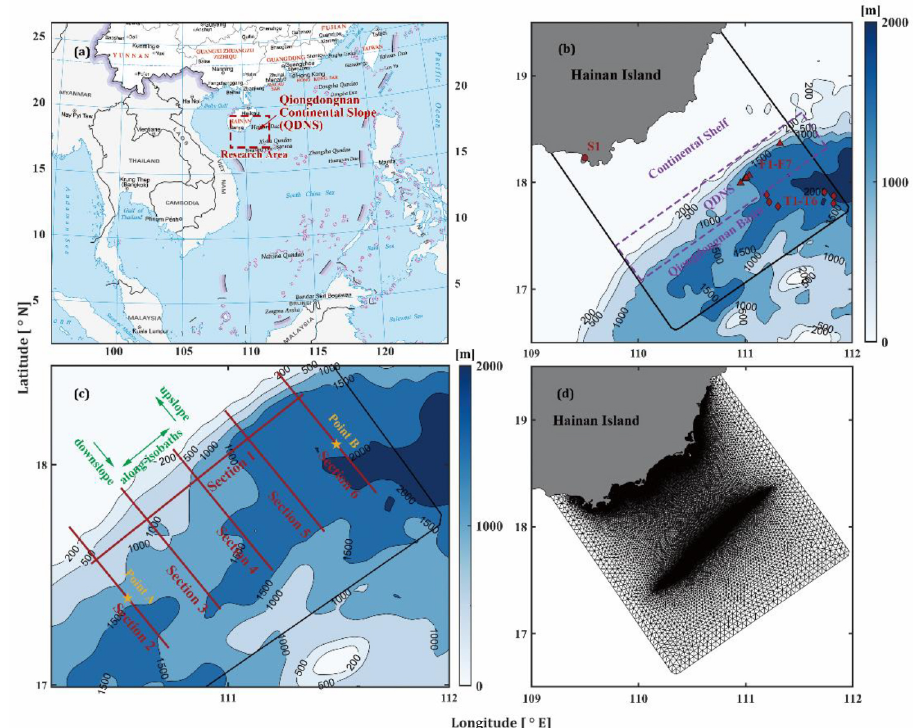
Figure 1. ( a ) Map showing the location of the QDNS and its adjacent seas. ( b ) Bathymetry of the research area in the northern SCS, where the black line defines the model domain. The red dot S1 (triangles F1–F7) indicates the sea level (flow) validation station, while thermohaline validation points T1-T6 are marked as red diamonds. ( c ) Bathymetry of the zoomed-in area around the QDNS. The red lines indicate six representative sections, the yellow stars indicate two represent points A and B, and the green arrows mark the downslope, upslope and along-isobaths direction. ( d ) The unstructured triangular grid of the numerical